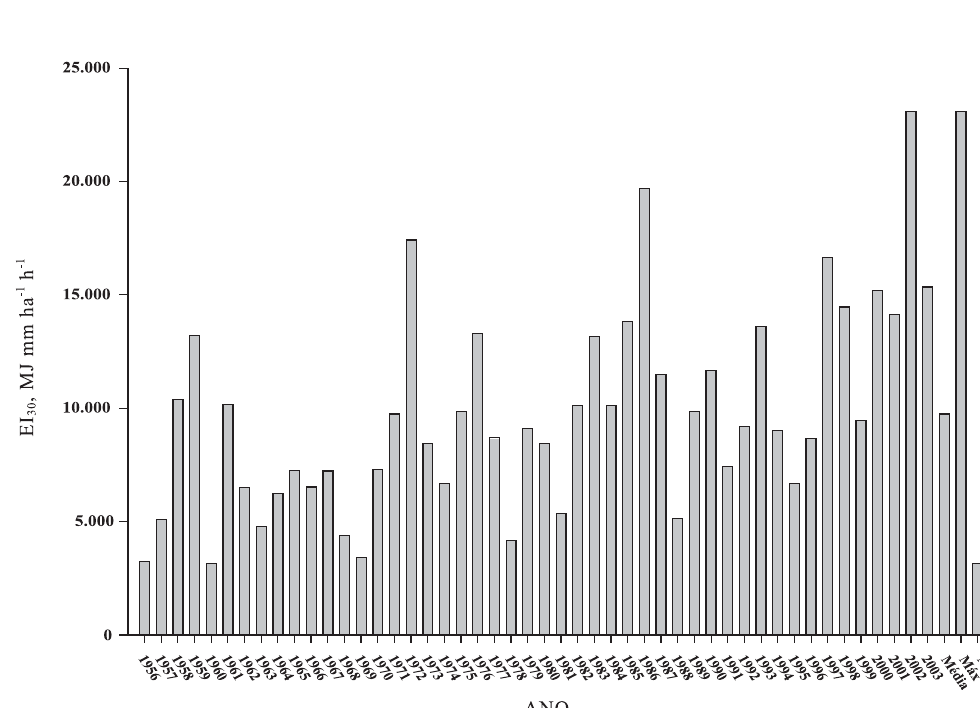
Figura 2. Erosividade anual das chuvas de São Borja, RS, determinada pelo índice EI